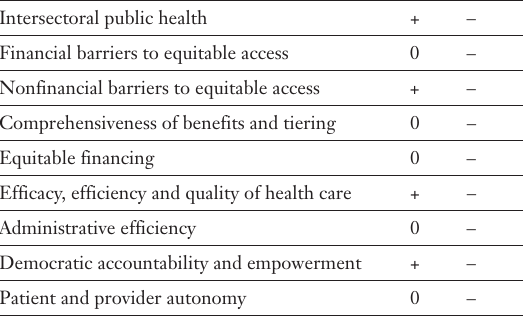
Figure 1 Scoring